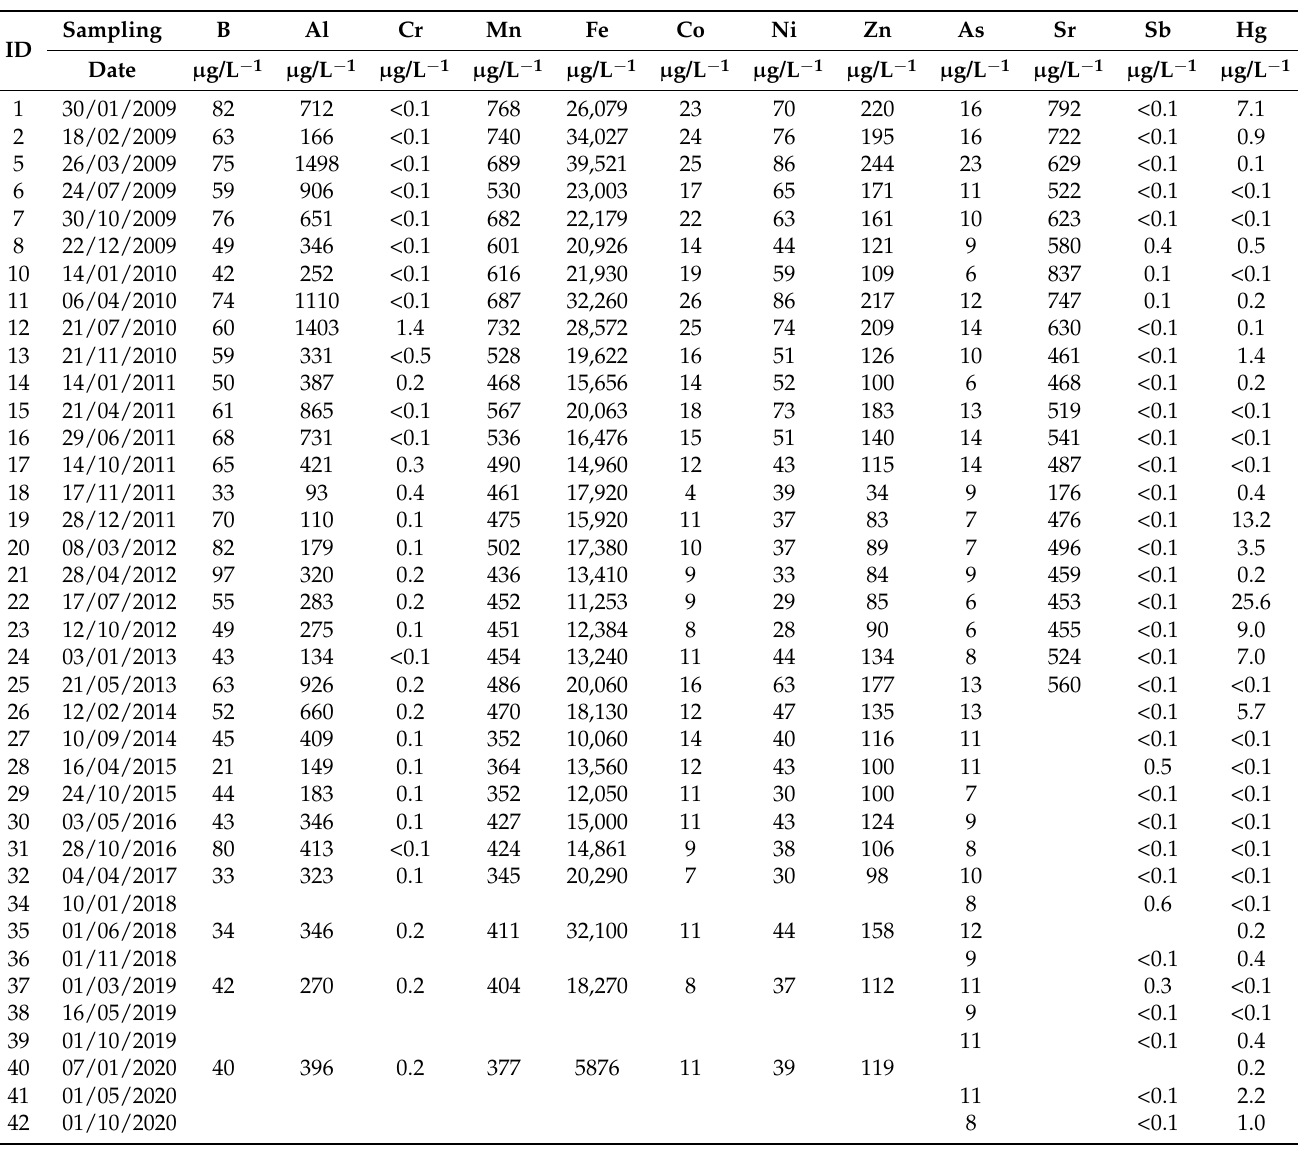
Table 2. Trace element concentrations of the Galleria Italia waters. The progressive numbers are those used in the diagrams to identify the sampling date. The sampling 3, 4, 9 and 33 are not listed because no data were available for trace elements. The Identification Number (IDs) are those used in the diagrams to refer to the sampling